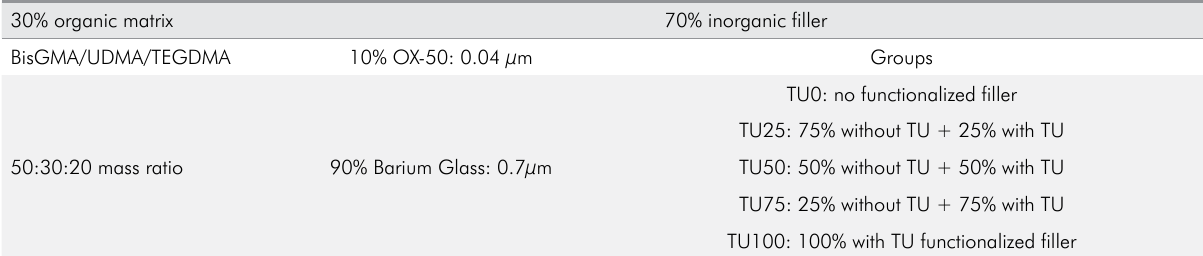
Table 1. Composite formulation and experimental groups definition . 30% organic